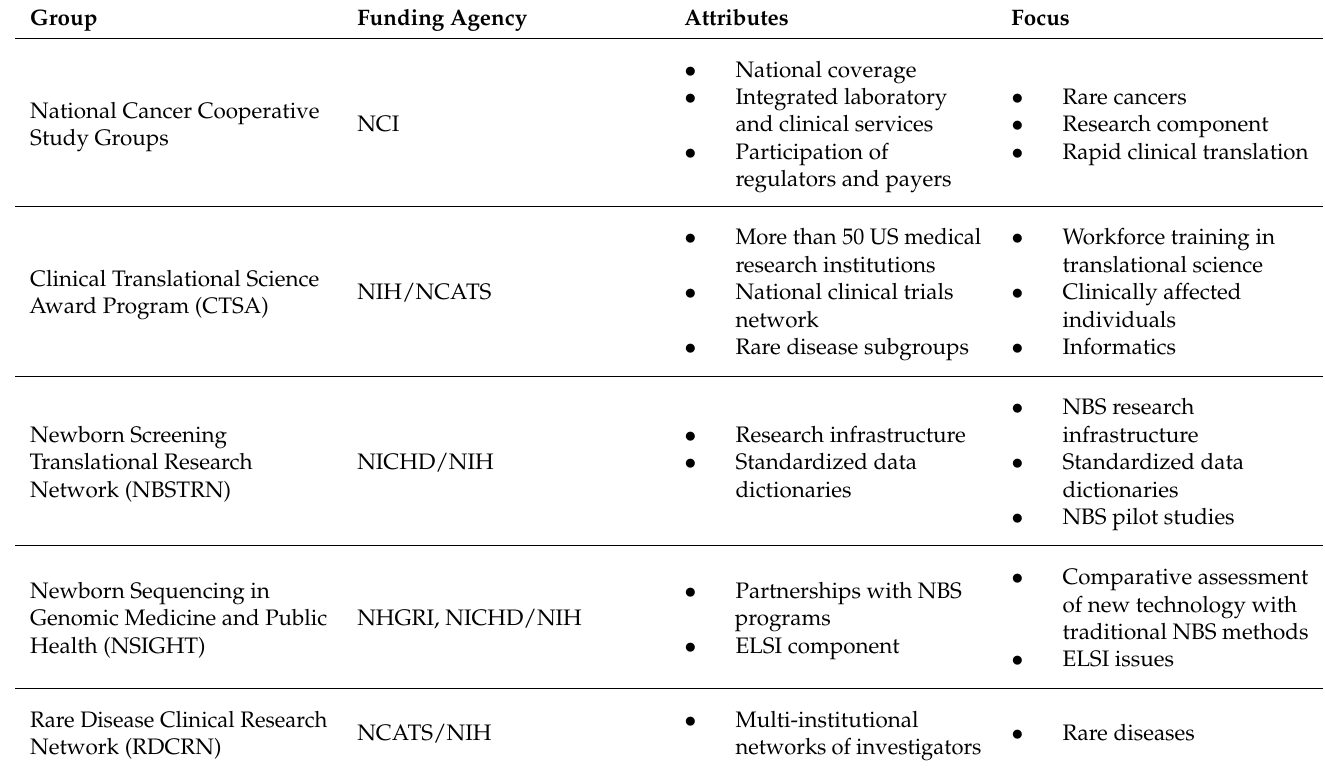
Table 3. Federal agencies supporting NBS